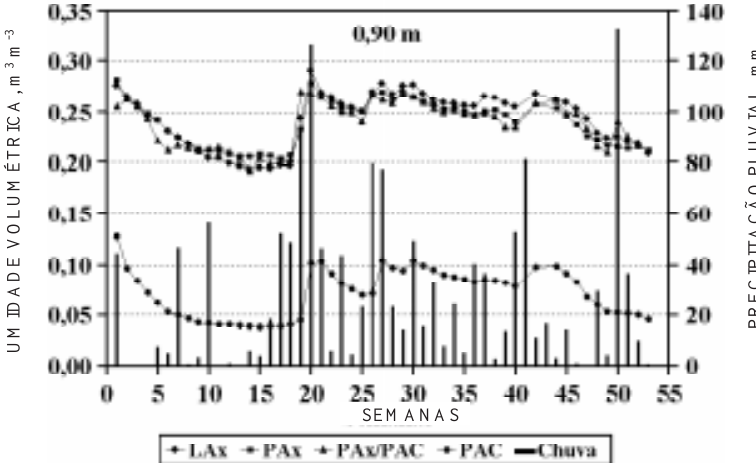
Figura 6. Variação da umidade nos solos Latossolo Amarelo argissólico (LAx), Argissolo Amarelo (PAx), solo transicional PAx/PAC e Argissolo Acinzentado (PAC), nas 53 semanas de avaliação, na profundidade de 0,90 m, e precipitação pluvial no período, em uma toposseqüência em tabuleiro do estado da